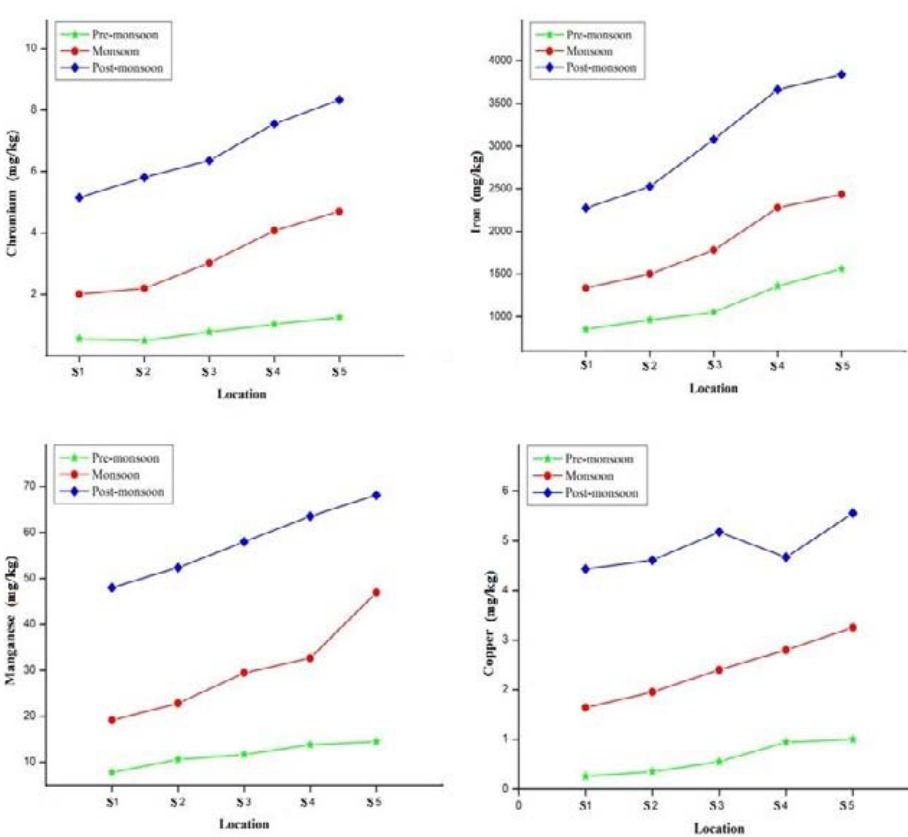
Fig. 2: Seasonal variation of Cr, Fe, Mn, and Cu in sediments